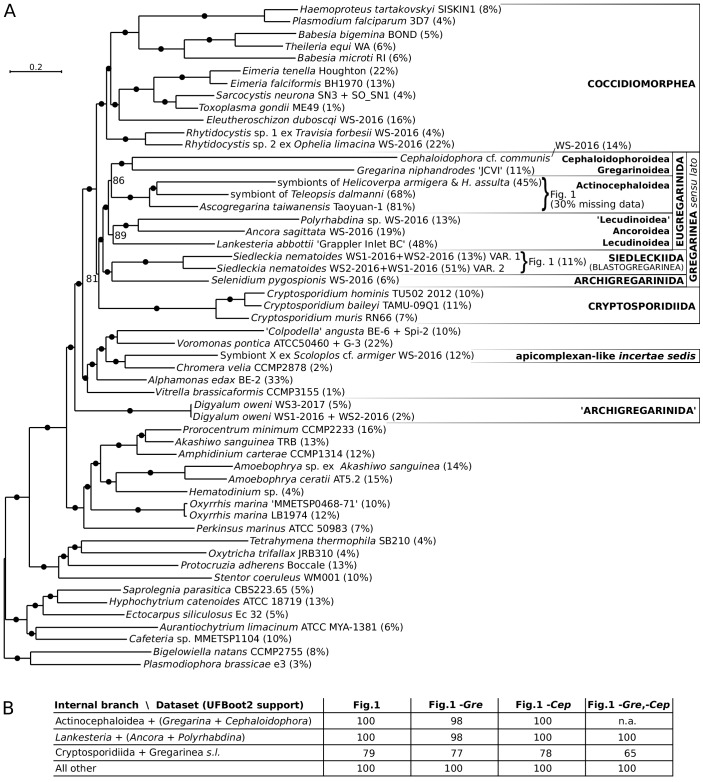
Multiprotein phylogenies of apicomplexans and related taxa.(A) Maximum likelihood tree (IQ-TREE) of apicomplexans and their relatives (54 species) based on 296 concatenated protein markers (99948 sites, 14.4% missing data). Values at branches correspond to UFBoot2 supports, black dots indicate 100 support (1000 replicates, LG+G4+F+C60+PMSF model). Sequences of three actinocephaloids and of the two distinct sequence variants in Siedleckia nematoides were merged in the Figure 1A dataset, as shown. Values in parentheses behind species names show % of missing data in the final phylogenetic matrix. Single quotation marks indicate potentially problematic taxonomic assignments. Sequence sources are in Supplementary file 2. (B) Maximum likelihood phylogenies on datasets that excluded the two fastest evolving taxa, Gregarina and Cephaloidophora, either individually or together (IQ-TREE). UFBoot2 supports are shown (LG+G4+F+C60+PMSF model); note that all trees were topologically congruent.